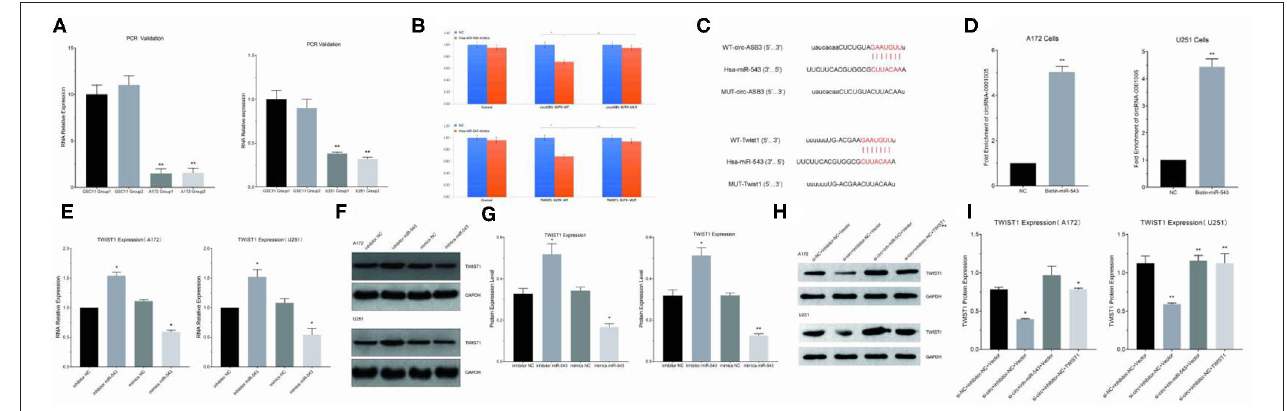
FIGURE 3 | Circ-ASB3 up-regulated Twist1 expression by sponging mR-543. (A) RT-PCR was used to detect relative expression of circ-ASB3 in GSC11 cells (Compared with A172 and U251). (B) Luciferase reporter activity of circ-ASB3/Twist1 in A172 cells was analyzed after co-transfected with miR-543 mimic and mimic control. (C) Schematic representation of circ-ASB3/Twist1 3 ′ -UTR in wild type and circ-ASB3/Twist1 3 ′ -UTR in mutant type, with mutations at the predicted miR-543 binding site. (D) RNA pull-down assay after transfection of biotin-labeled oligo and miR-543 probes in A172 cells. (E) RT-PCR detection of Twist1 mRNA in A172 cells after transfected with miR-543 inhibitor and mimics. (F,G) Twist1 expression was identified using western blot assays after transfected with miR-543 inhibitor and mimics. (H,I) Twist1 expression was identified using western blot assays after transfected with si-circ-ASB3, miR-543 inhibitor and Twist1 mimics. The data are the MEAN ± SEM of three experiments, * P < 0.05, ** P < 0.01; representative images are